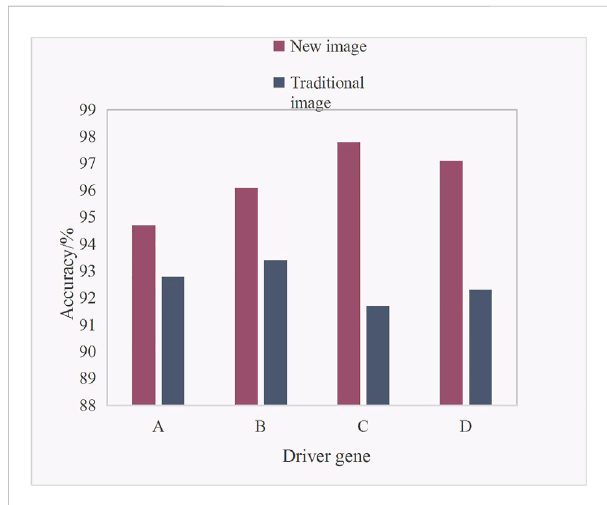
FIGURE 3 Accuracy analysis of early lung adenocarcinoma in lung